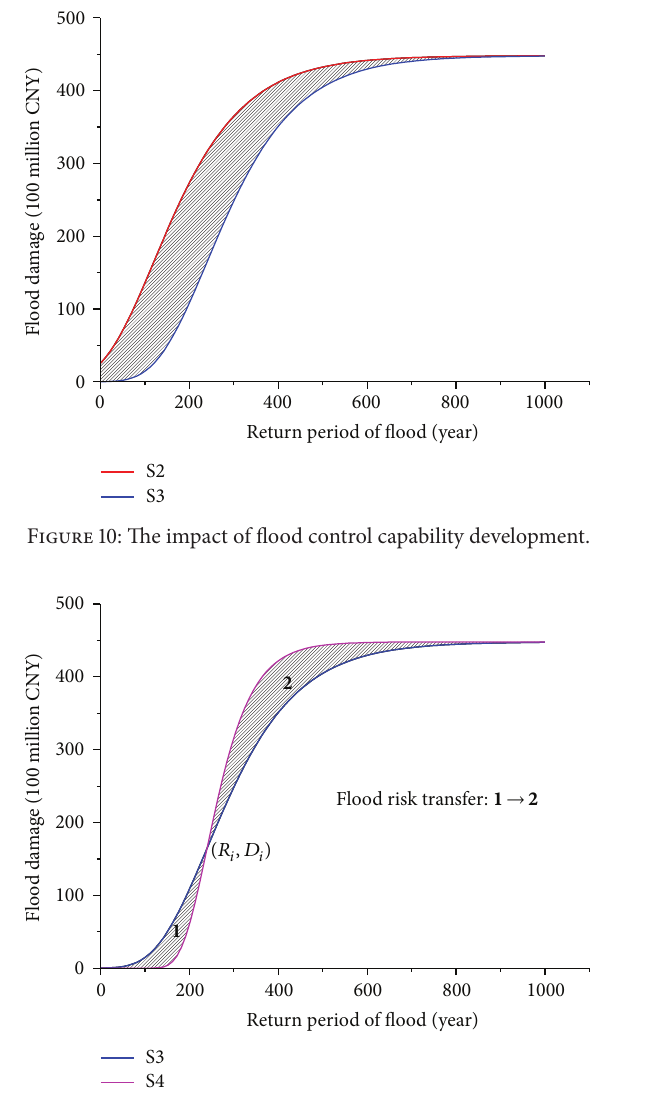
Figure 11: The impact of flood vulnerability change.